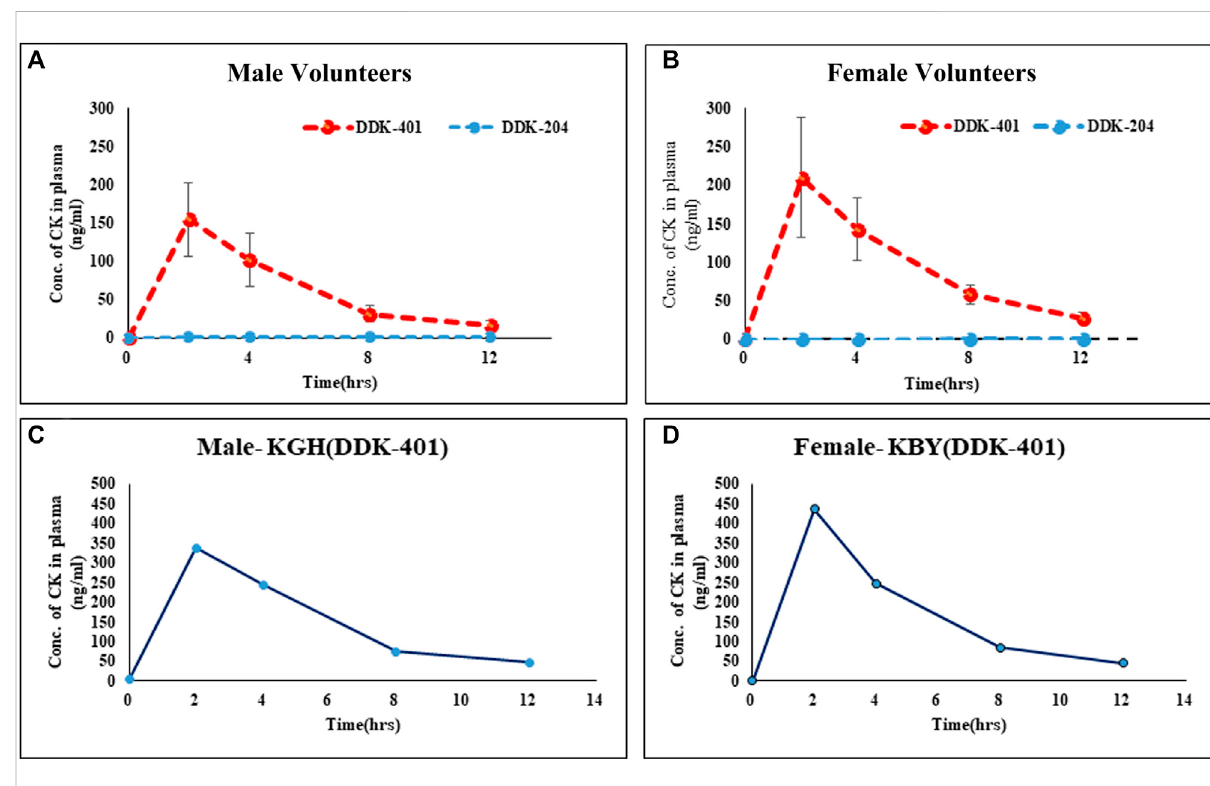
FIGURE 3 Absorption pro fi les of CK in human blood serum after oral intake of fermented red ginseng extract (DDK-401) and red ginseng extract (DDK- 204): (A) male volunteers, (B) female volunteers; maximum CK absorption in individual (C) male and (D)